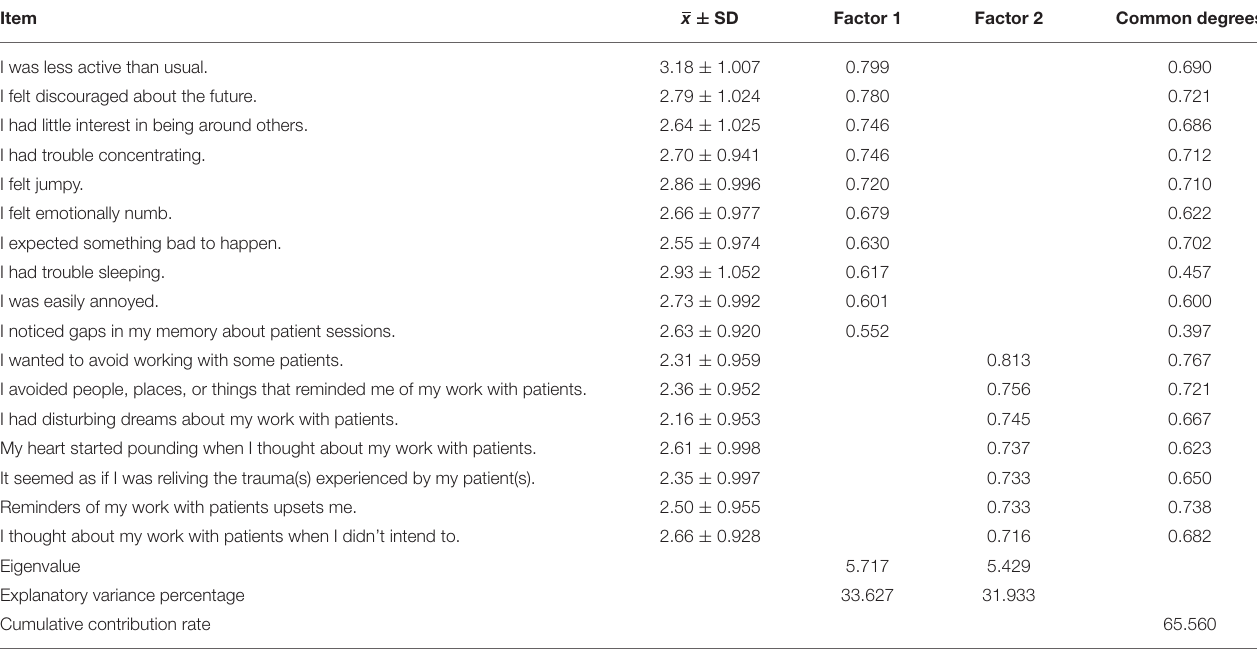
TABLE 2 | C-STSS exploratory factor analysis results ( n = 460). Item x ± SD Factor 1